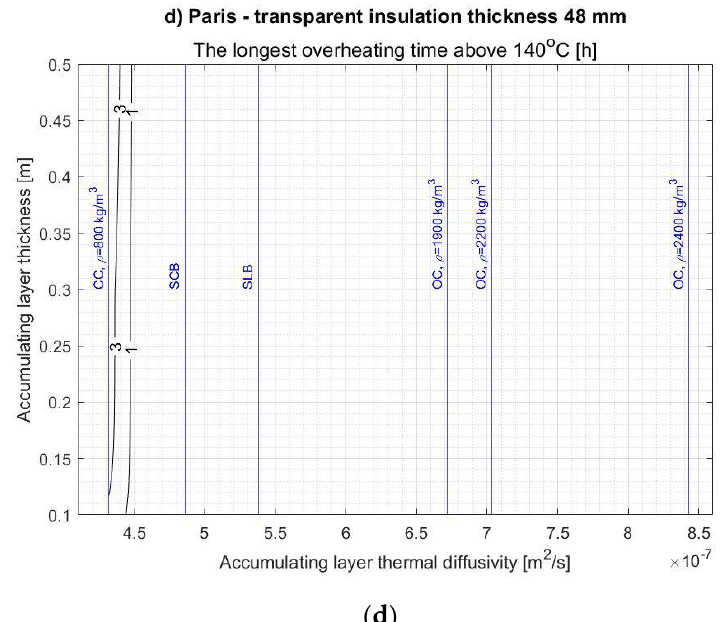
Figure A7. Contour graphs characterizing the SW basic parameters in a function of AL thermal diffusivity and thickness for the whole heating season: ( a ) the heat balance of the SW’s unit area, ( b ) the heating time, ( c ) the mean time lag of the maximum temperature on the absorber and SW’s internal surface during the day, ( d ) the longest overheating time above 140 °C in the TI. TI thickness: 48 mm. Location: Paris.